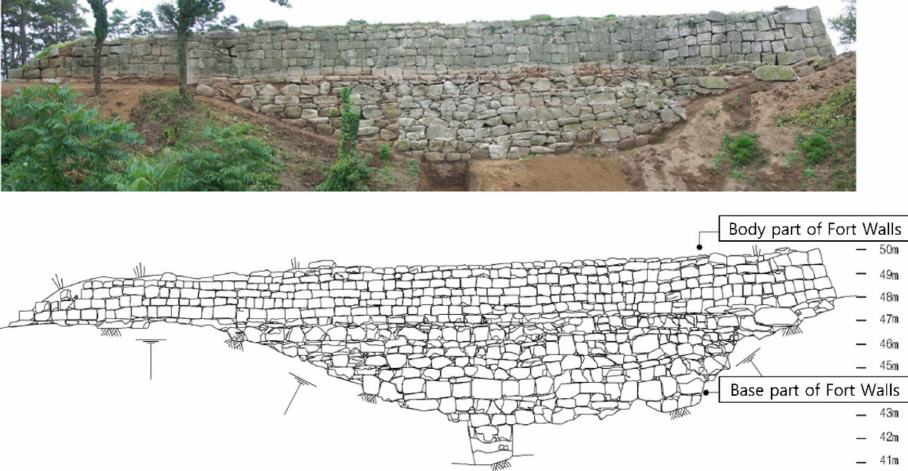
Figure 5. Gyeryong Dondae, East Exterior Body Part. Reprinted with permission from Ref. [32]. 2010, Hanul Cultural Heritage Research Institute.